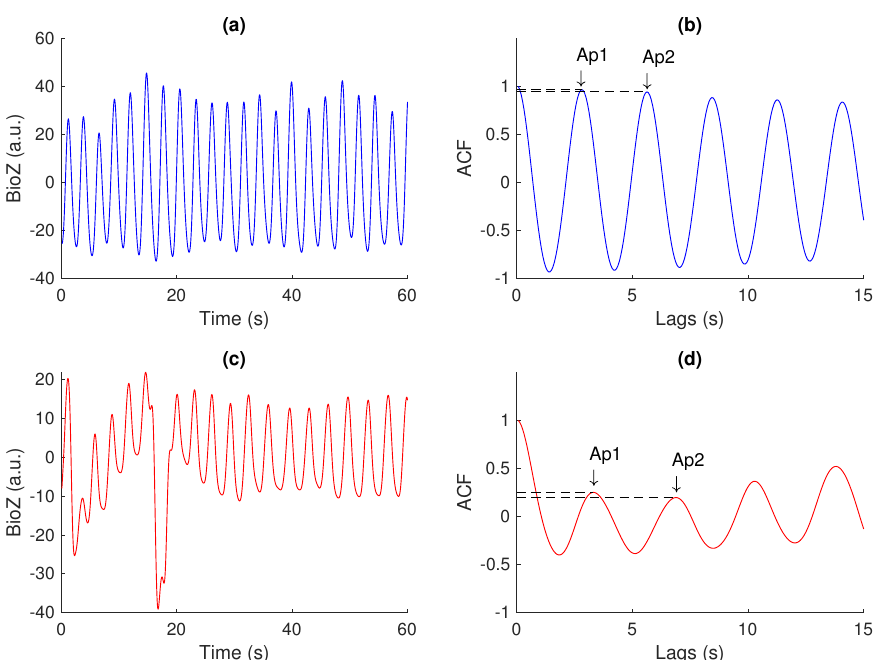
Figure 4. ( a , c ) A clean and noisy BioZ signal during normal breathing. ( b , d ) The resulting auto correlation functions (ACFs). It can be observed that the amplitude of the first and second peak for the clean signal is higher, compared to the noisy